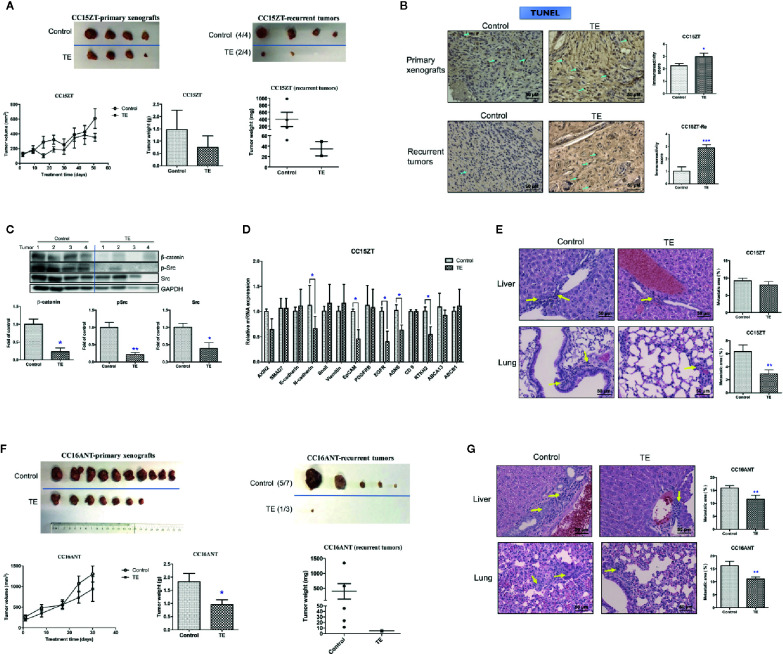
Effects of TE treatment on the growth of PDX and the recurrence of tumor. Mice bearing PDX samples CC15ZT and CC16ANT were treated with TE and the primary xenografts were removed by surgery. For the CC15ZT PDX sample, (A) tumor volume changes, final tumor weight and photo of primary xenografts were shown on the left panel. The final tumor weight and photo of recurrent tumors were shown on the right panel. The tumor incidence was listed in the brackets next to the photo. (B) Representative images of TUNEL in primary xenografts and recurrent tumor sections and quantitative results of positive-stained cells in the tumor sections were shown. Bar = 50 μm. Data were presented as mean ± SEM. n = 20 sections in each group. (C) Western blot of primary xenograft protein against β-catenin, p-Src, Src, and GAPDH and the quantitative data presented as fold of vehicle control. (D) Real-time PCR of selected gene expressions in the primary xenografts. GAPDH was used for normalization. n = 4 tumors in each group. (E) Liver and lung sections were stained with H&E and the metastatic area (shown by yellow arrows) was assessed. n = 20 sections in each group. Quantitative results of liver and lung metastasis were shown on the right panel. For the CC16ANT PDX sample, (F) tumor volume changes, final tumor weight and photo of primary xenografts were shown on the left panel. The final tumor weight and photo of recurrent tumors were shown on the right panel. The tumor incidence was listed in the brackets next to the photo. (G) Liver and lung sections were stained with H&E and the metastatic area (shown by yellow arrows) was assessed. n = 15–25 sections in each group. Data were shown as mean ± SEM. *
p < 0.05, **
p < 0.01, ***
p < 0.001 vs. vehicle control.